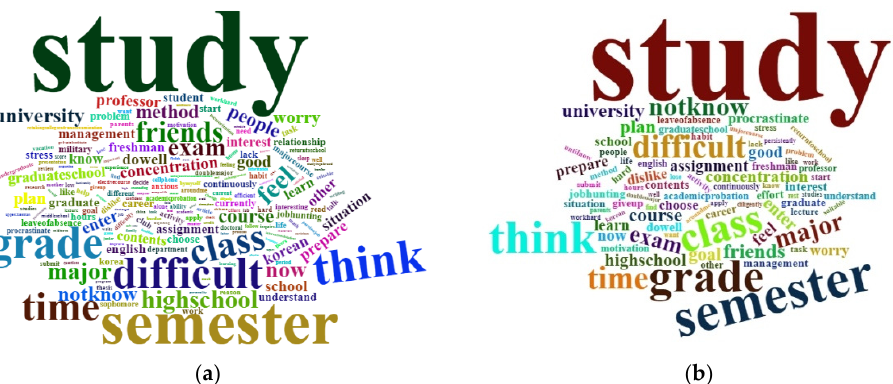
Figure 2. ( a ) Wordcloud of keywords before COVID-19; ( b ) Wordcloud of keywords after COVID-19.